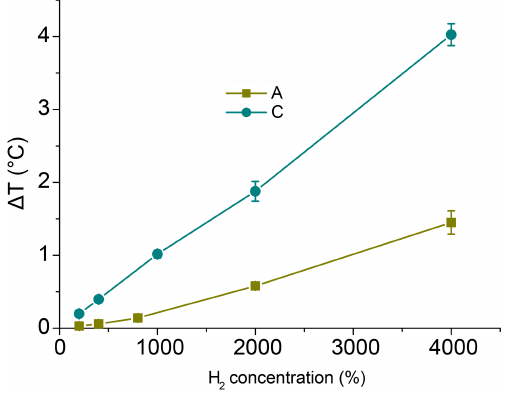
Figure 6. Stability of the thermal response of sample C to different concentrations of H 2 in dry air for 120s. Figure 7. Linear response of the sensitivity of catalysts A and